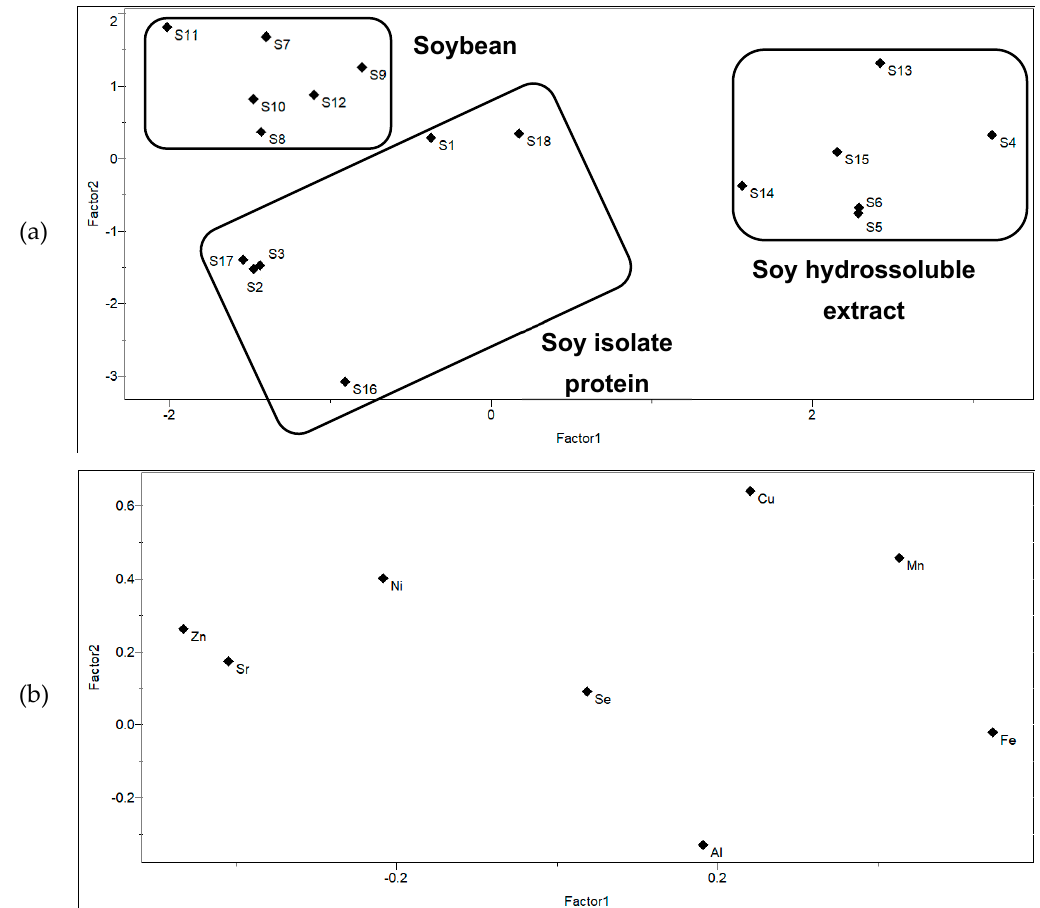
Figure 1. Principal component analysis for trace elements in soy-based beverages: ( a ) scores plot; ( b ) loading plot.